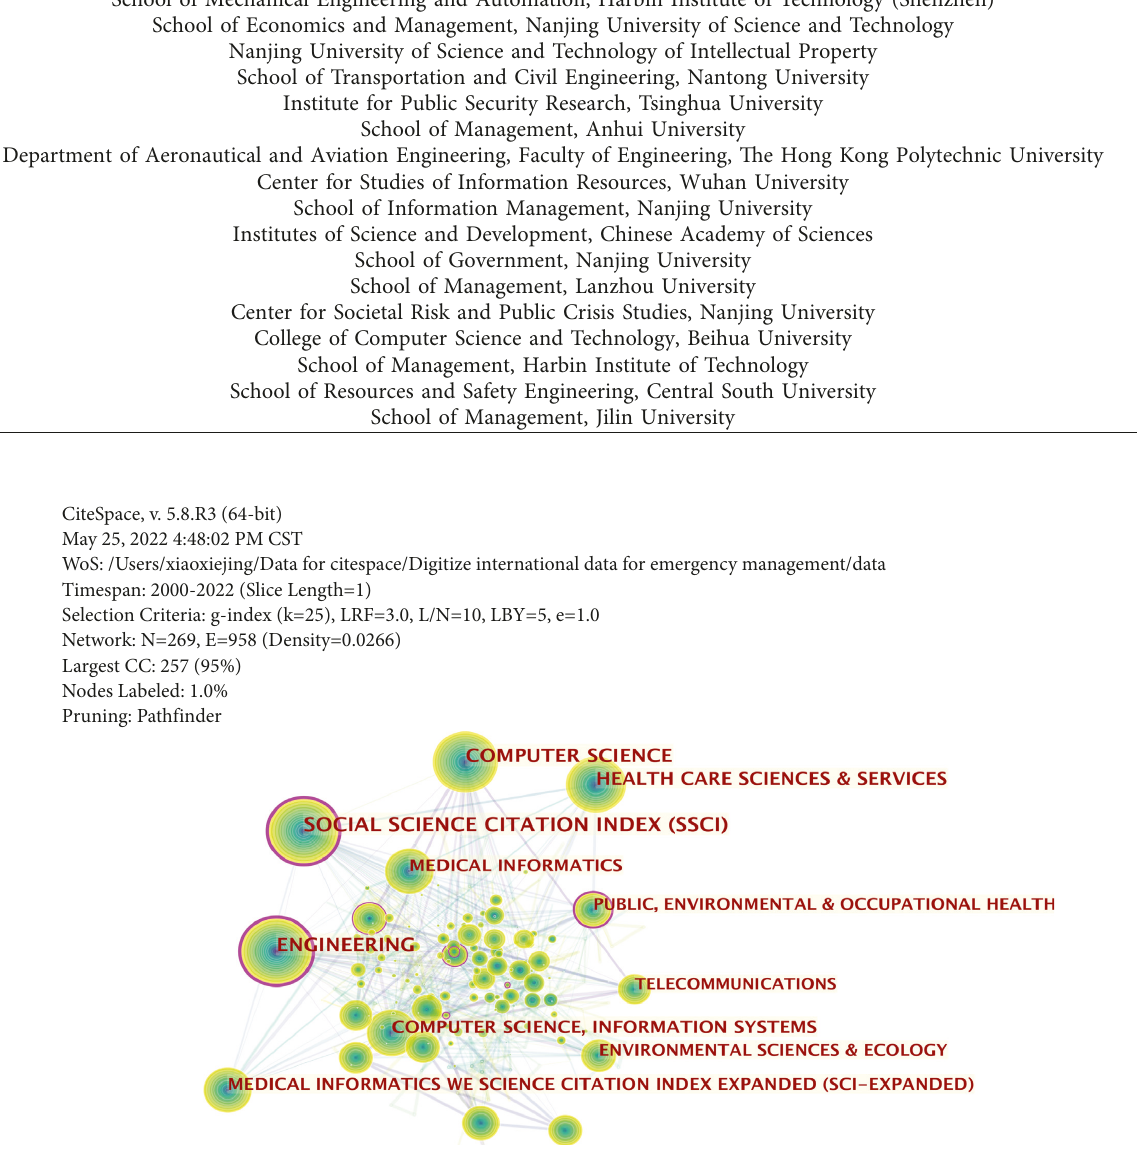
Figure 6: Disciplines’ distribution map of international DEM